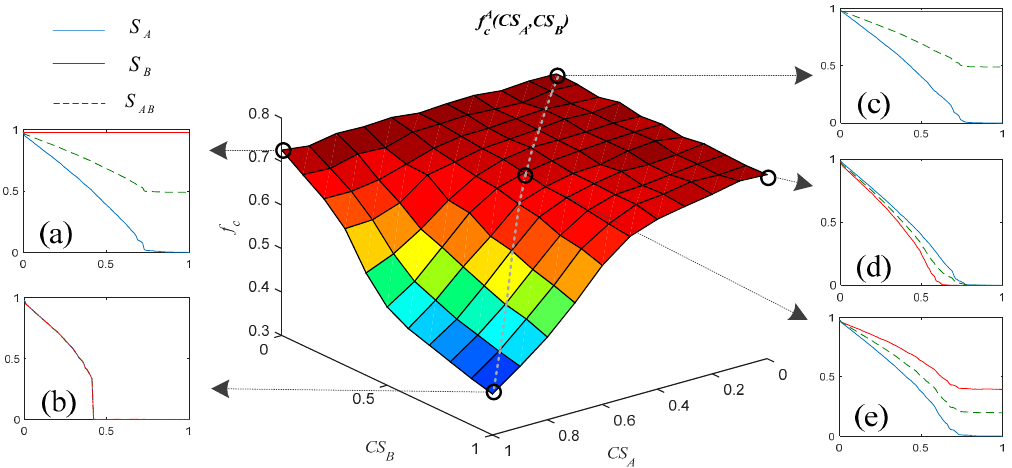
Figure 4. Relationship between collapse threshold f c and coupling strength ( CS ) on both unilateral and bilateral failure modes.